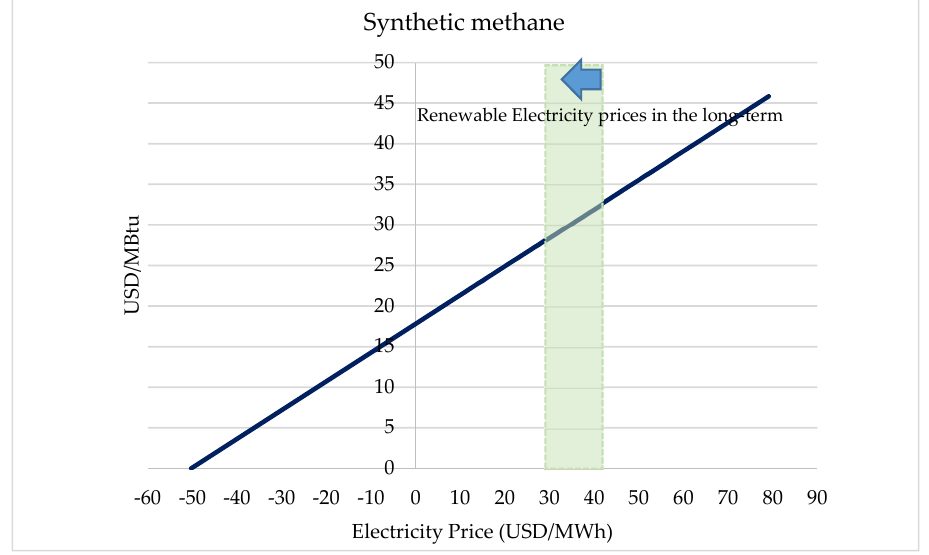
Figure 5. Synthetic methane production cost based on 3000 FLH (full load hours) of electrolyser. MBtu = million British thermal units. Negative electricity prices reflect local intermittent excess production (extrapolated from the original data). For more information on the underlying assumptions refer to [25].